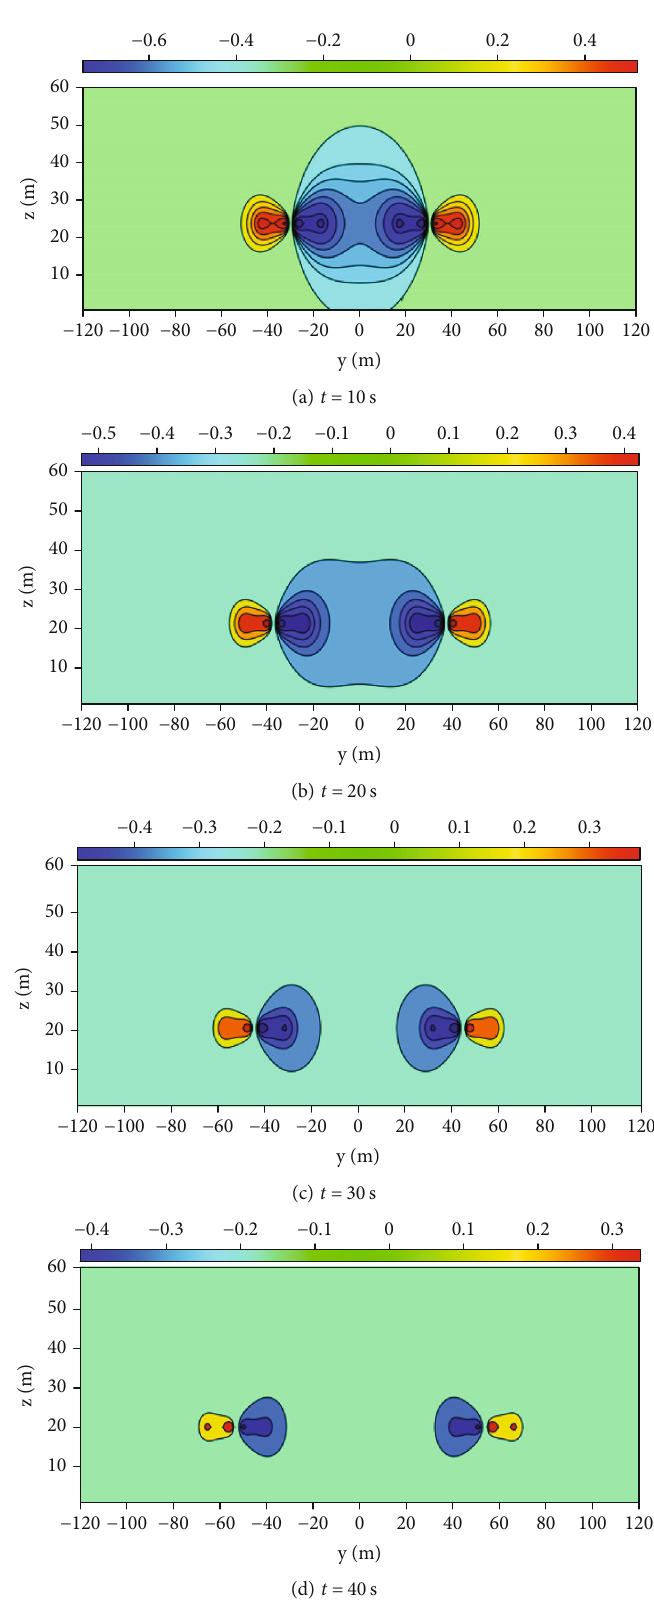
Figure 20: Variation in the wake overload hazard zone with time at a 30-m